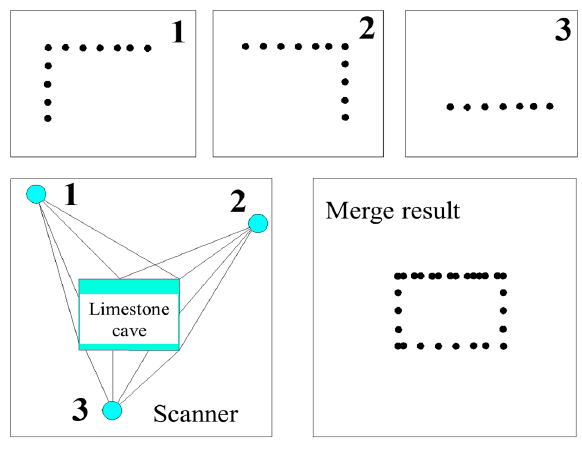
Figure 7. Mosaic of multi-point scanning data.